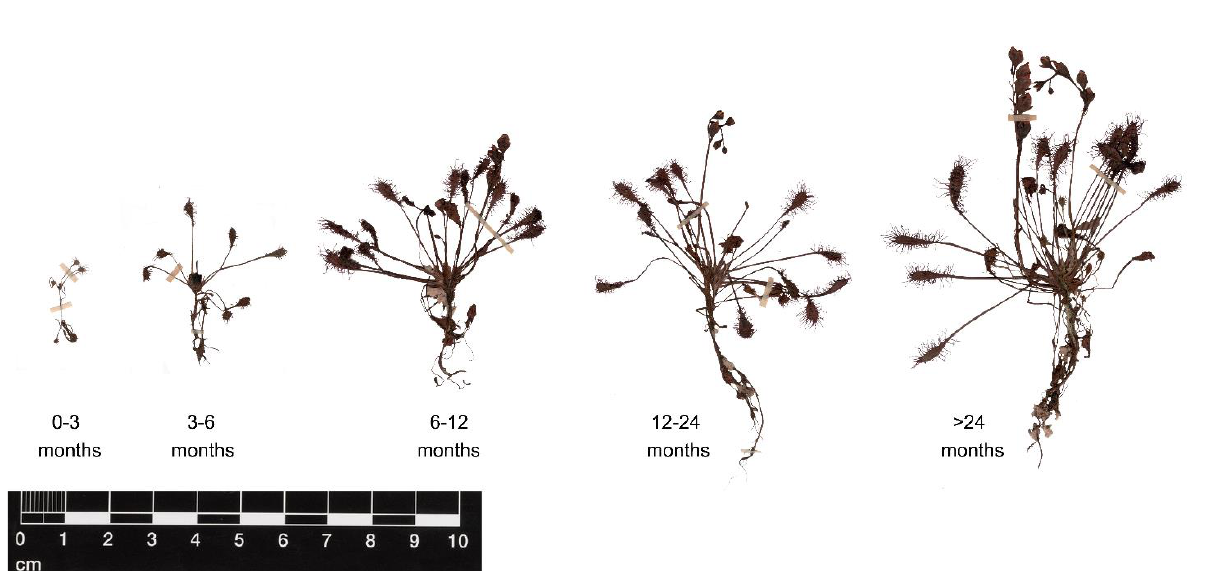
Figure A1. Drosera intermedia plants by age class, collected on the Sphagnum papillosum field of the Sphagnum farm in Rastede (north-west Germany). Collected and determined by Balázs Baranyai, 17 August 2014.